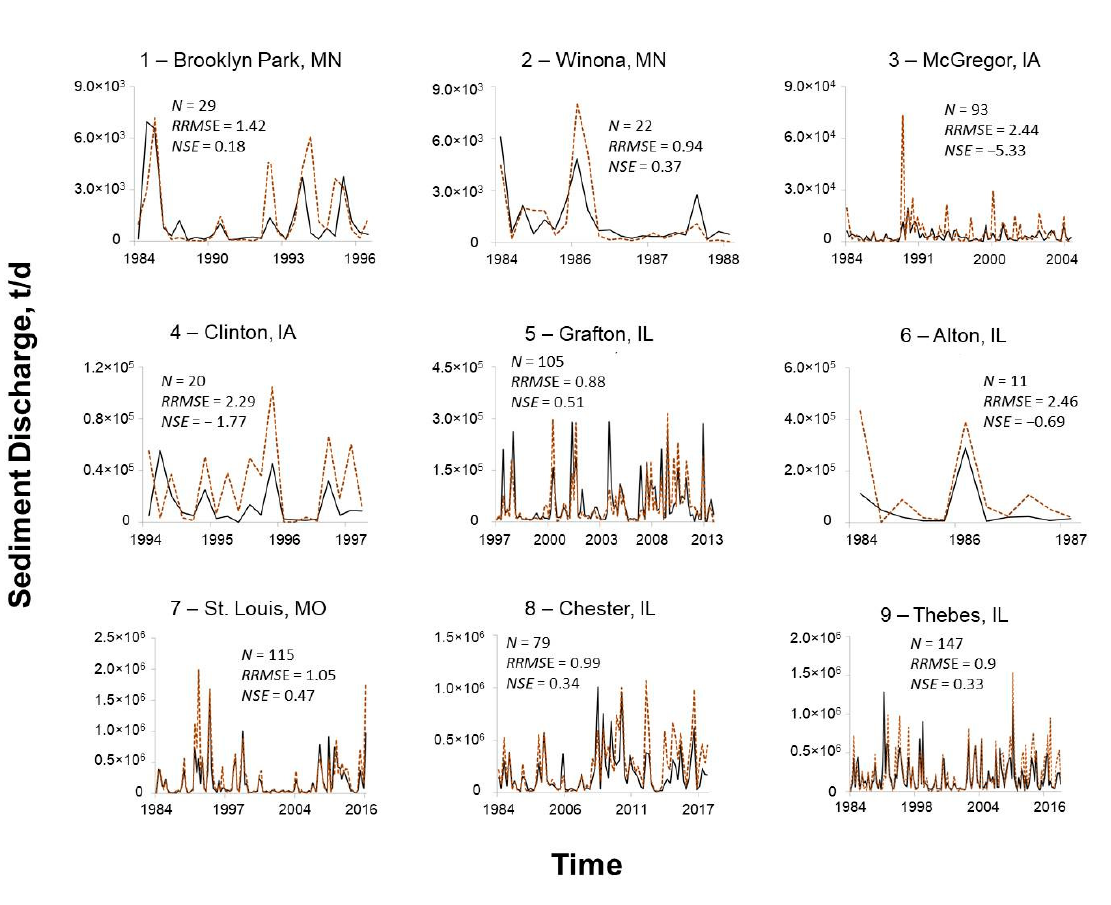
Table 7. Model performance of sediment discharge estimation for the individual study sites.